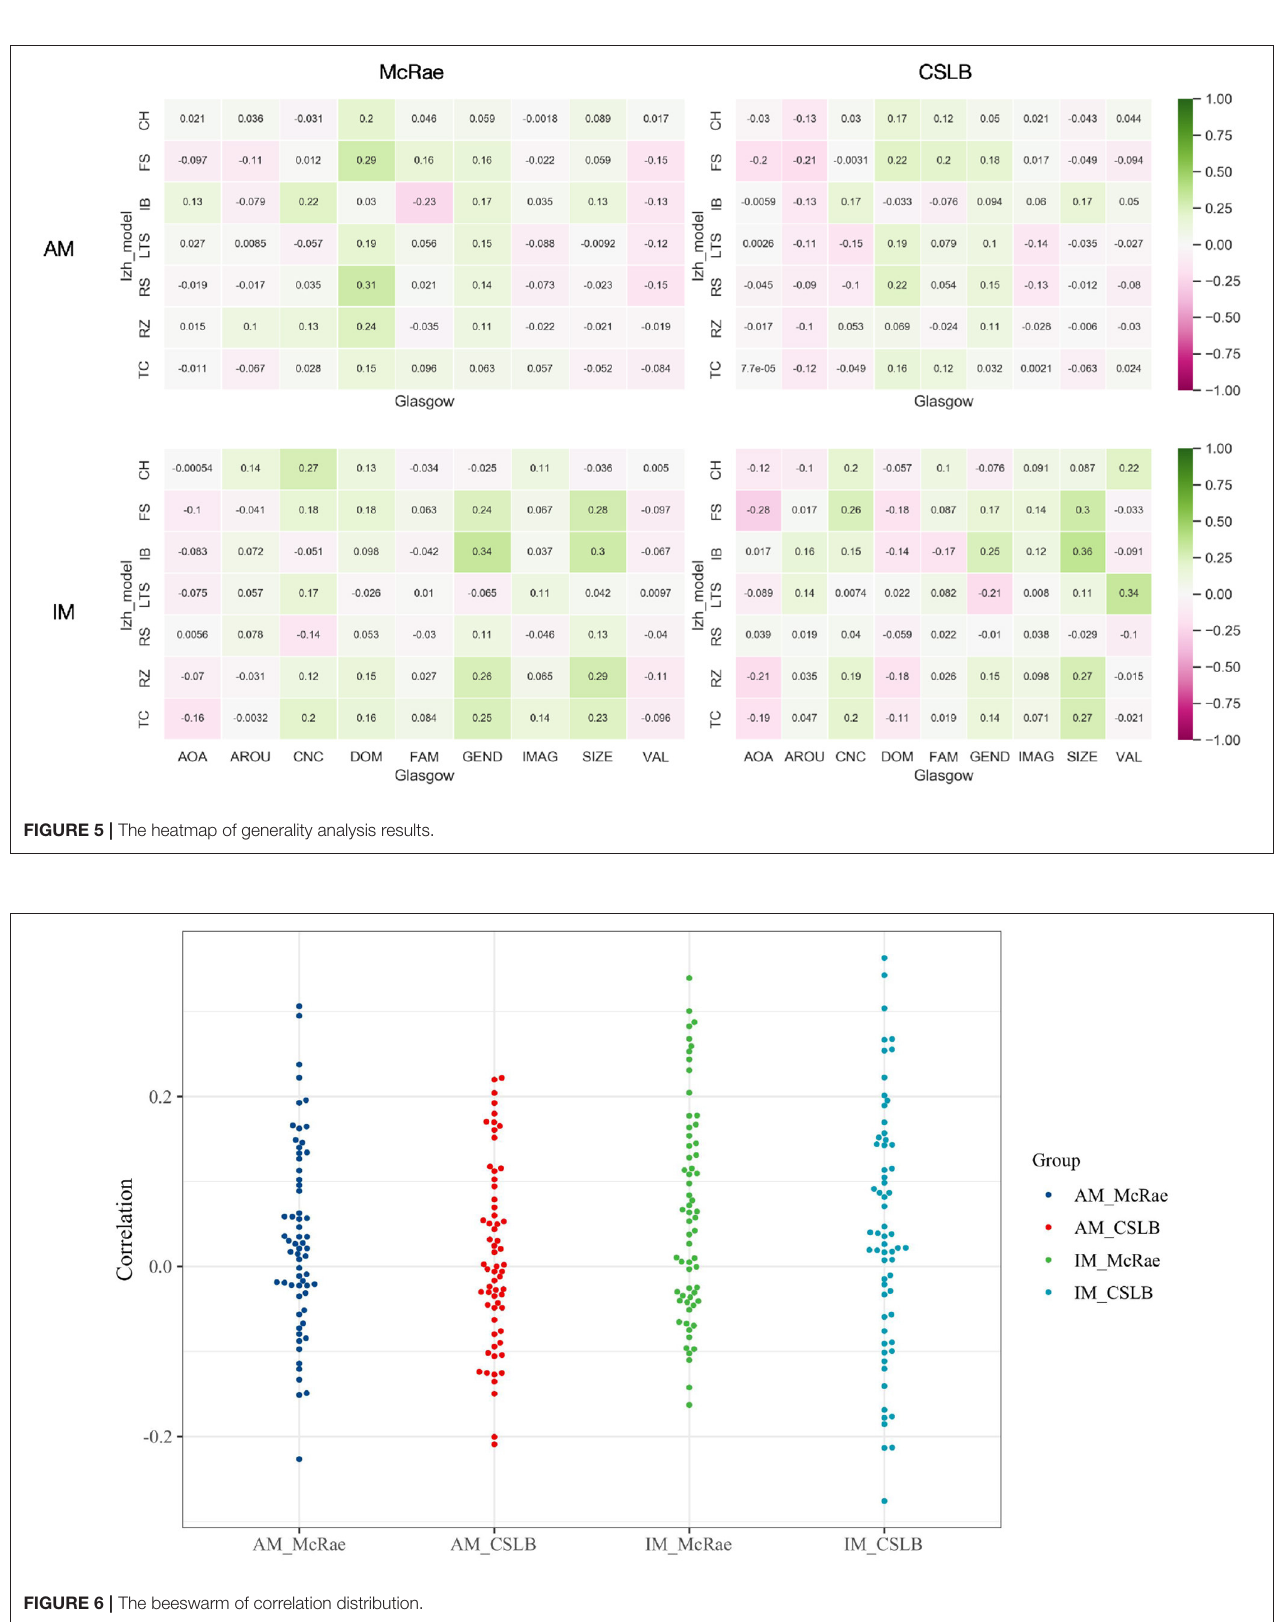
FIGURE 6 | The beeswarm of correlation